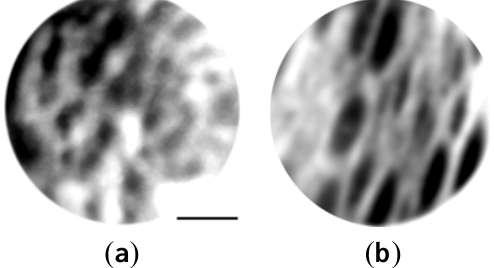
Ti Cu Ni Be BMG at ( a ) 17.0 kV and ( b ) 18.5 41 14 12.5 10 22.5